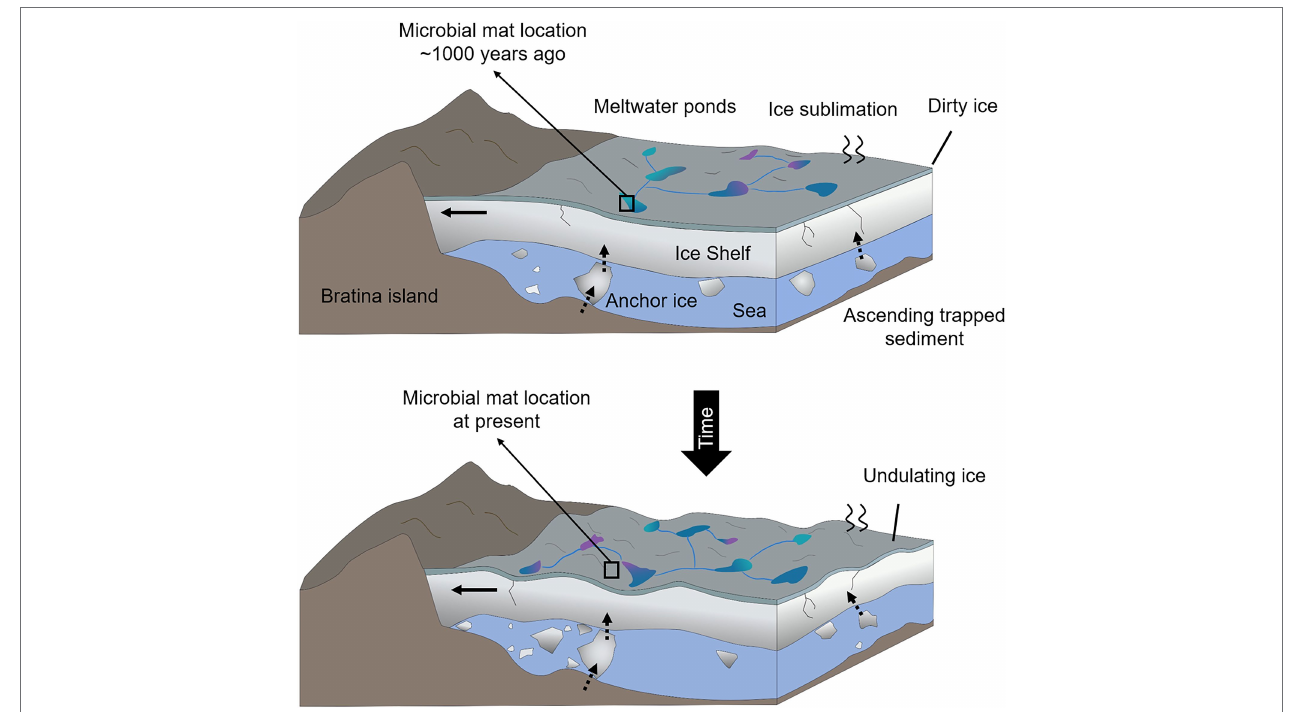
FIGURE 2 | Sketch of the temporal shifts and physical processes occurring in the MIS close to the coast of Bratina Island. Horizontal black arrows in the ice shelf indicate the sense and direction of the ice compression against the coast of Bratina Island that causes the undulation of the ice. Vertical and inclined dashed arrows represent the sense and direction of the debris ascension as a result of the ice basal accretion and surface ablation. Different colors of the meltwate ponds represent a mixture of conditions (e.g., different salinities), and black boxes indicate the hypothetical location of the microbial mat ~1,000 years ago (submerged in a meltwater pond) and at present (desiccated and exposed to atmospheric